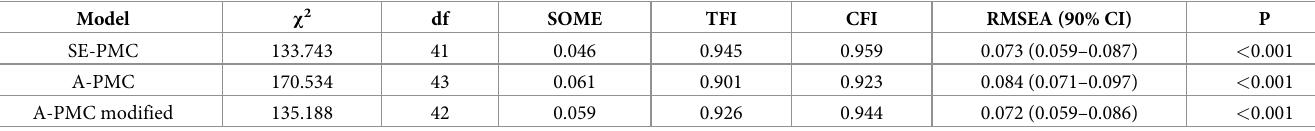
Table 3. Model fit indices from the confirmatory factor analysis (n =